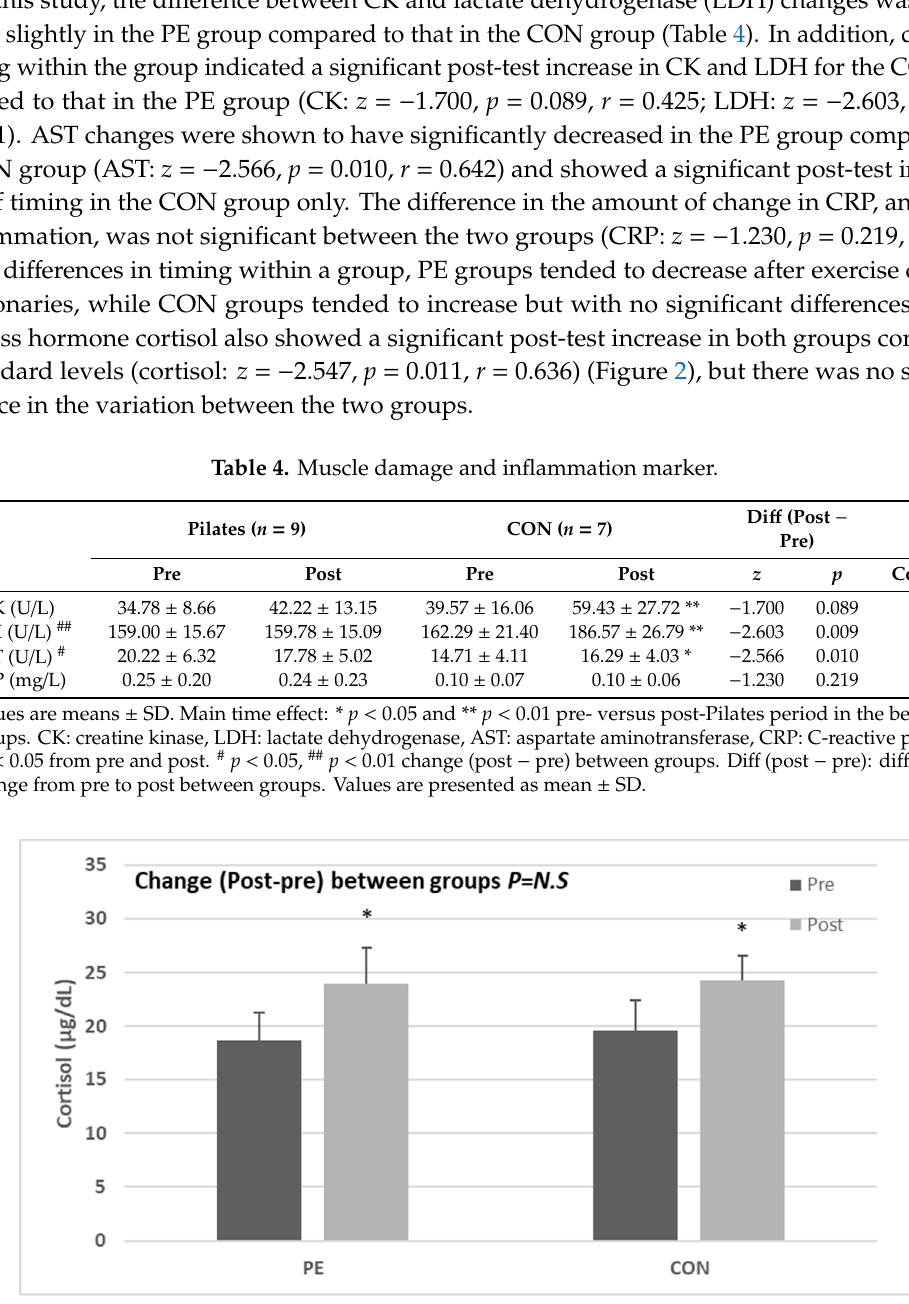
Figure 2. Effect of Pilates exercise on cortisol hormone level, bars represent mean ± SD (PE: n = 9, CON: 7, per group). * p < 0.05 from Pre to Post. PE: Pilates exercise group, CON: control group